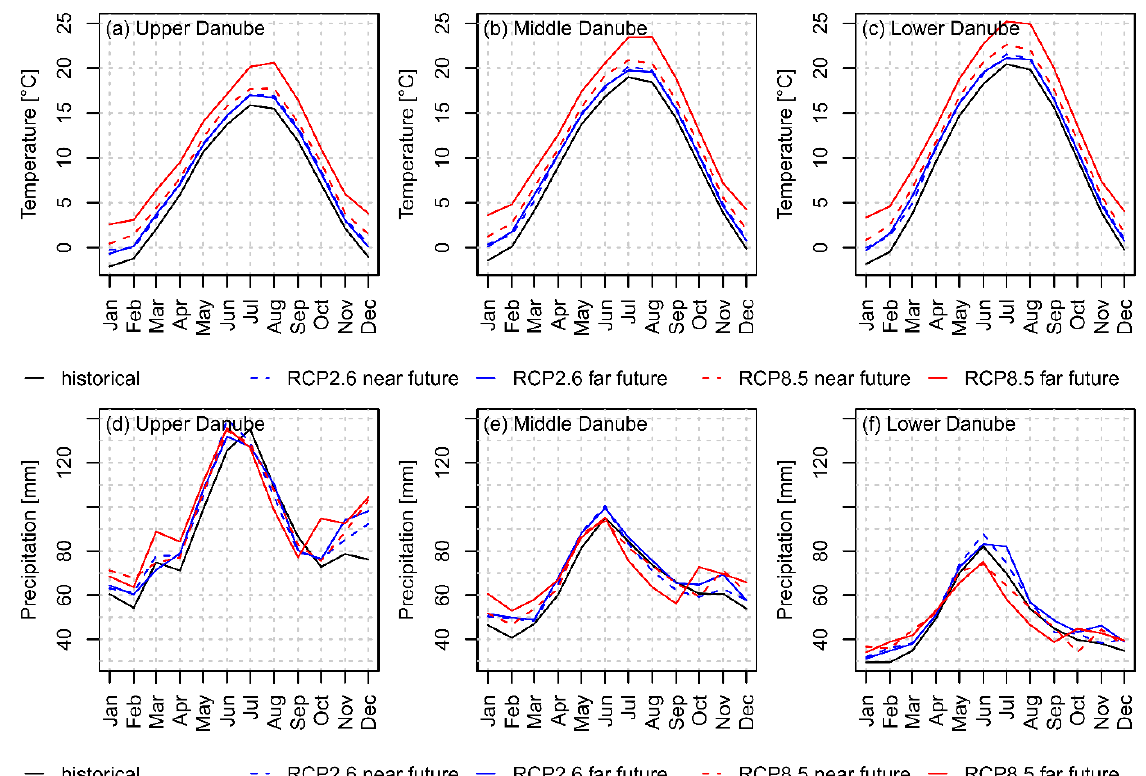
Figure 5. Long-term mean monthly developments of temperature [°C] ( a – c ) and precipitation [mm] ( d – f ) according to the historical GCM-RCM-driven simulations (ensemble mean, 1971–2000) and the GCM-RCM-driven simulations (ensemble mean) under RCP2.6 and RCP8.5 for the near future (2031–2060) and the far future (2071–2100) on spatial average for the Upper, Middle and Lower Danube.